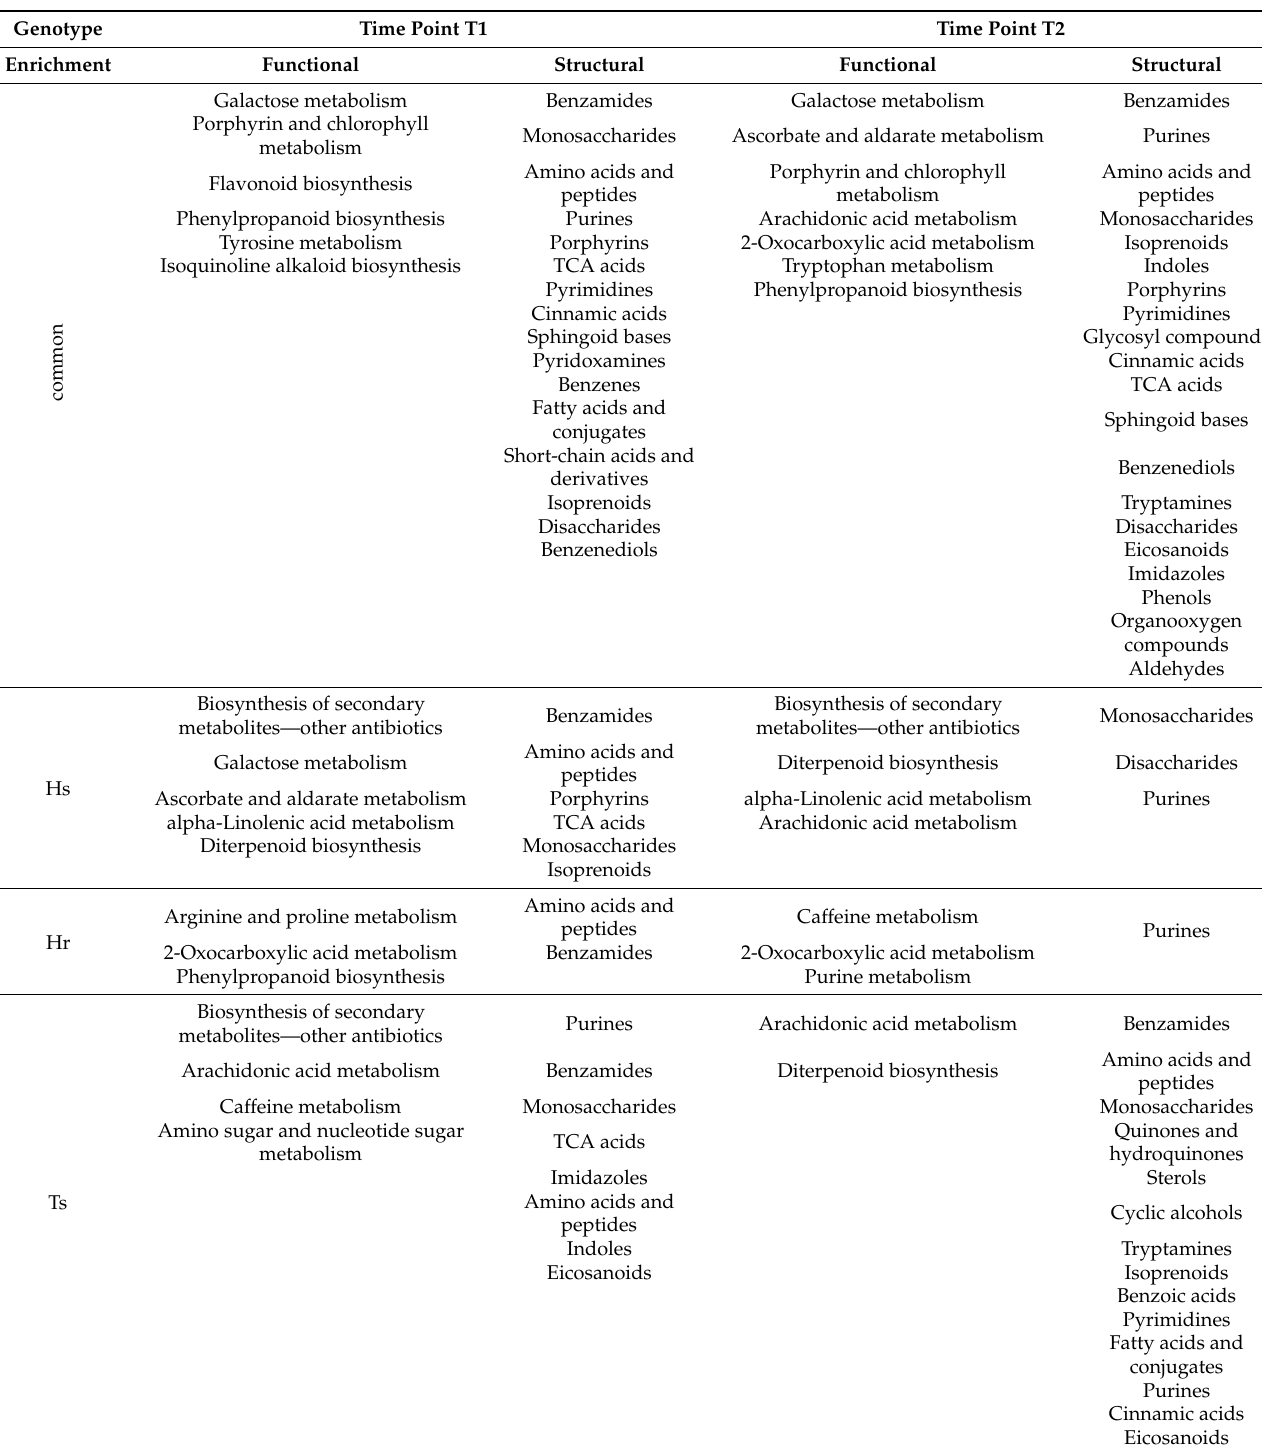
Table 1. Enrichment analysis of LC-MS signals annotated to KEGG Metabolic pathways and structural groups selected as the most enriched for common DAMs. Only pathways with FDR of matching <0.3 and pathway impact I > 0.5 were presented in table as statistically significant. Entire functional enrichment results and compounds annotation can be found in Table S3. Only structural classes enriched with FDR of matching <0.01 were presented in table as statistically significant. Entire structural enrichment results can be found in Table